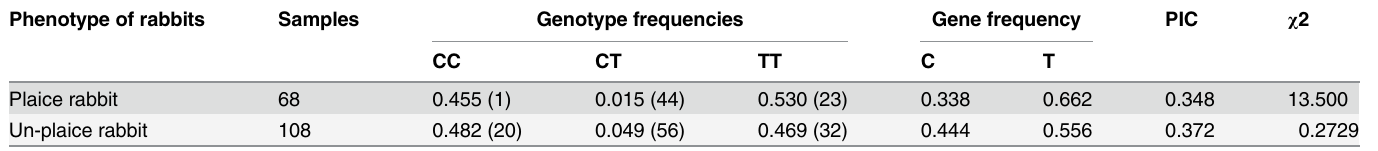
Table 5. Genetic diversity of eighth exon of lamb3 in white Rex Rabbit.